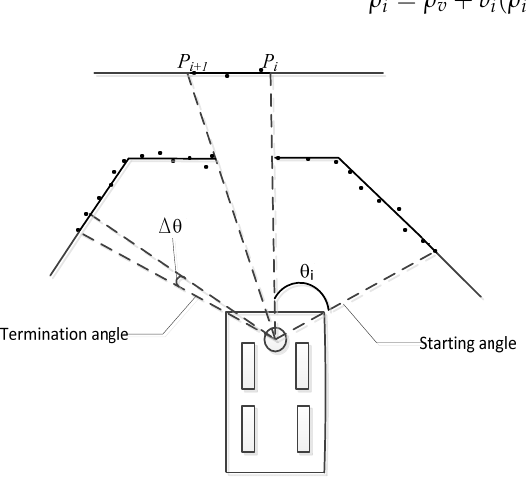
Figure 1. Radar ranging model.